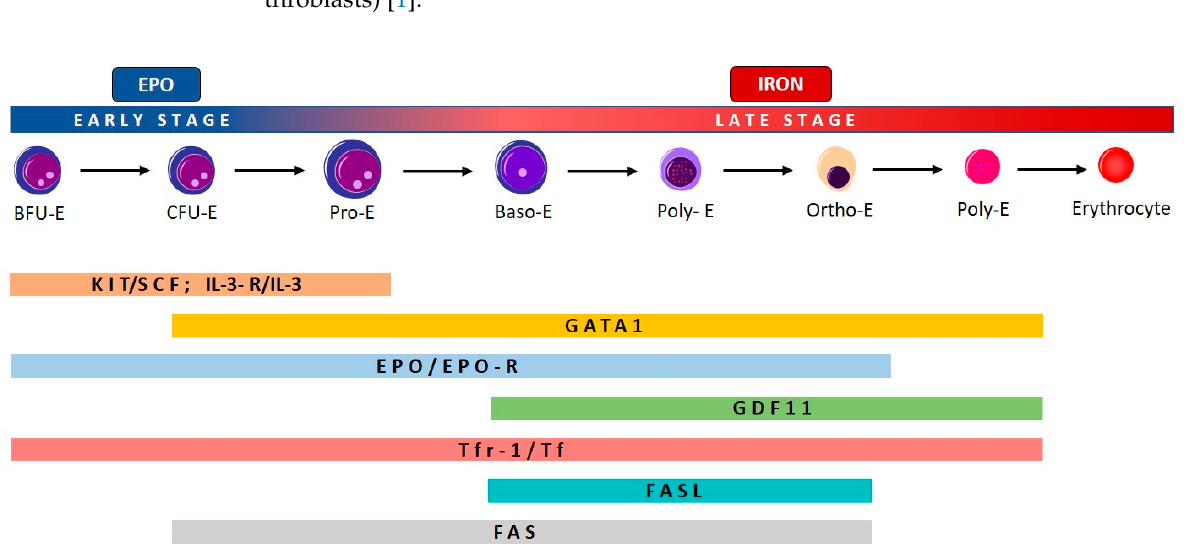
Figure 1. Schematic representation of erythroid development and time-dependent expression of a complex network of transcription factors involved in the process. EPO-dependent and iron-dependent stages of erythropoiesis are indicated. Differentiation, maturation, and proliferation of erythroid progenitors are regulated by several molecules according to different stages. Stem cell factor (SCF), interleukin-3 (IL-3) and their receptors progressively disappear during erythroid maturation, after the Pro-E stage. GATA1 promotes erythropoiesis and increases the EPO receptor (EPO-R) expression, which is maintained until the Ortho-E stage. In turn, EPO is the main regulator of early-stage erythropoiesis, after the BFU-E stage. Other molecules are regulators of iron metabolism, such as transferrin (Tf) and its cell receptor (Tfr), growth/differentiating factor 11 (GDF11) and members of the transforming growth factor (TGF)- β family, which negatively regulate erythrocyte differentiation and maturation from the early stages (Tf/Tfr-1) to the late stages (Poly-E). Finally, the binding between FAS and FAS ligand (FASL) triggers the apoptosis of immature erythroid cells, acting from the CFU-E to the Ortho-E stages.